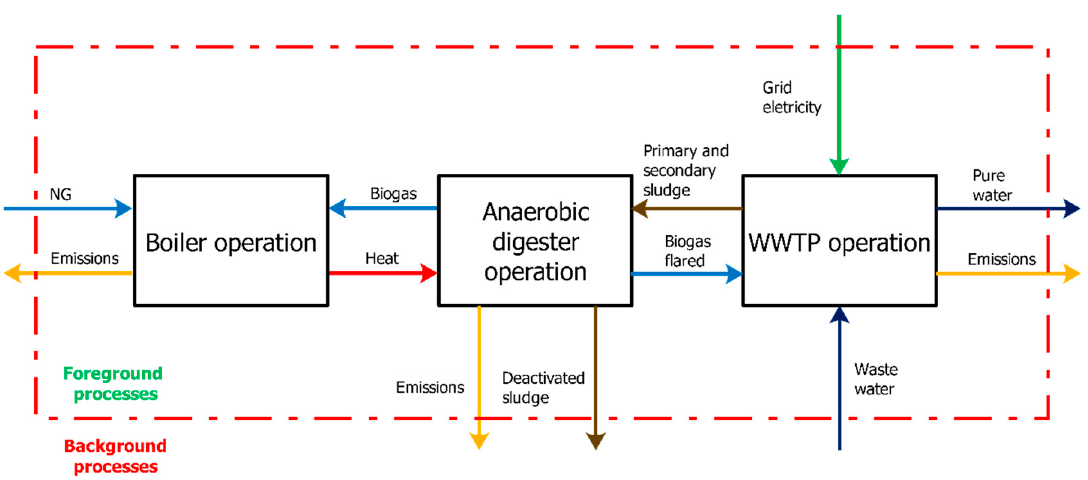
Figure 4. Boundaries of the reference WWTP (Scenario 1).